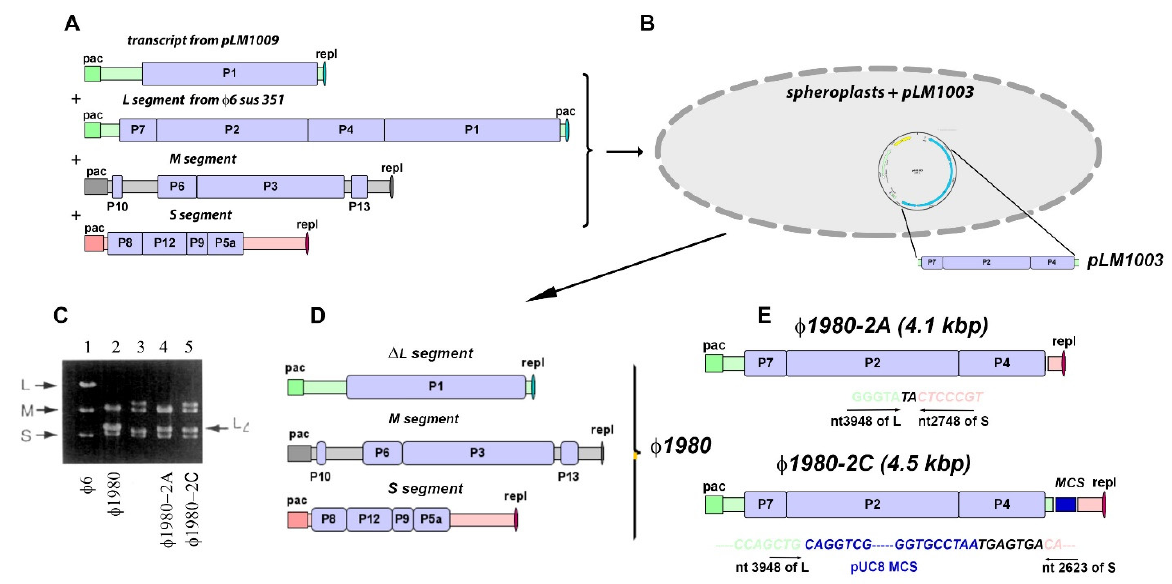
Figure 9. Recombinant phages can acquire the missing genes from the donor plasmid expressed in Pseudomonas host cells. ( A ) Transcripts of partial segment of L (pLM1009), isolated l segment from mutant carrying amber mutation from ϕ 6 sus351, and complete ssRNA from m and s segments of ϕ 6 are in vitro packaged in PC and coated with P8, transducing the spheroplasts of HB10Y with plasmid pLM1003, coding the missing 2, 4, and 7 genes and MCS of pUC8 ( B ). The phage ϕ 1980 carries at least two L segments and M and S segments ( C , D ). On the dsRNA agarose gel picture reproduced from Onodera et al. (1995) ( C ), the pattern of ϕ 1980 dsRNA shows a higher intensity of the L band compared to any of the dsRNA bands from the control ϕ 6 dsRNA pattern. If the ϕ 1980 was plated on HB10Y host without donor plasmid pLM1003, the extremely rare lytic plaques were all recombinants. ( E ) The phages packed an extra segment bearing missing 2, 4, and 7 genes and the replication signal from either the M or the S segment. The recombinants had minimal homology (the homology regions are shown as bold black symbols, whereas the recombined RNA origins are shown as light green for the L segment, light pink for S, and blue for pUC8 MCS). Based on Onodera et al. (1995).